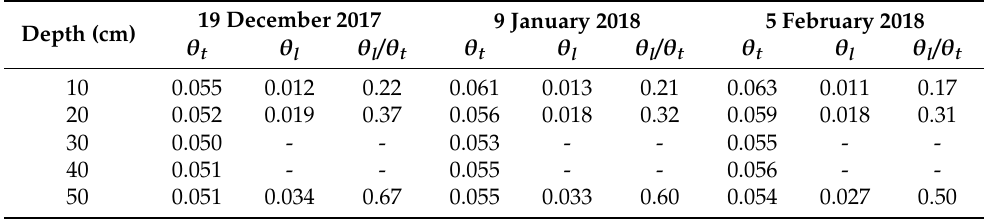
Table 6. The total soil water content θ t (cm 3 / cm 3 ) measured using the drying method and the liquid soil water content θ l (cm 3 / cm 3 ) measured using the Hydra Probe II sensors at di ff erent soil depths and at di ff erent times. Depth (cm)